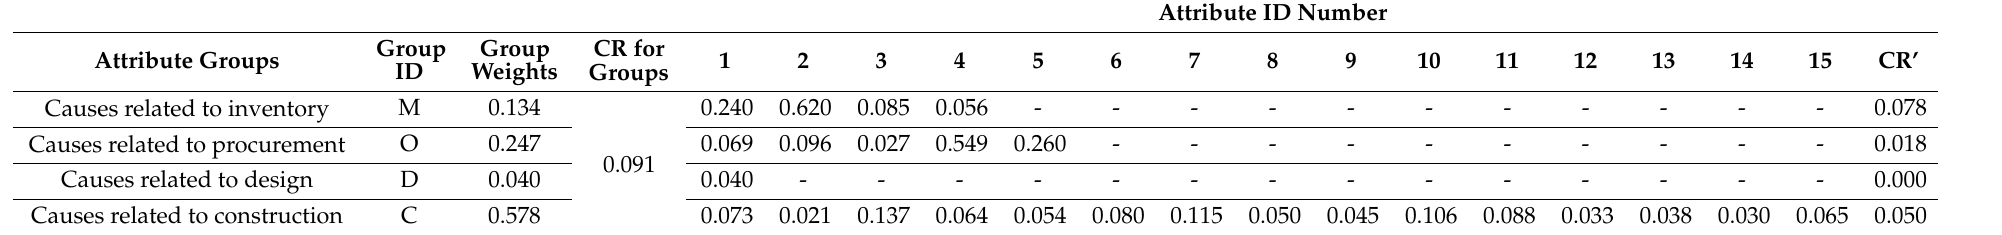
Table 8. Attribute weights after AHP